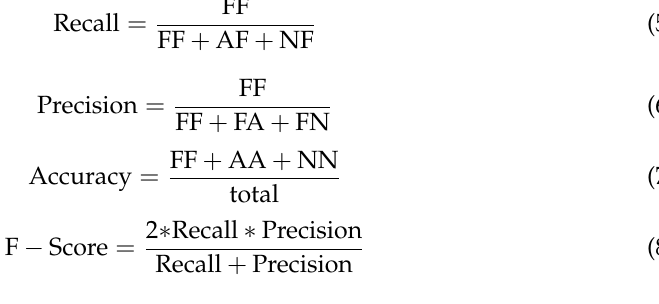
Table 3. General 3 × 3 Confusion